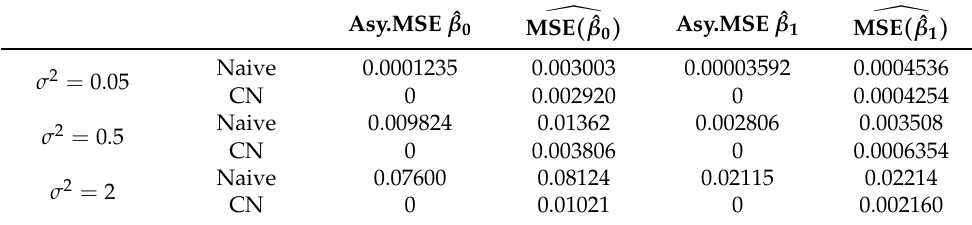
Table 2. Estimated MSE of a Gamma distribution with a normal